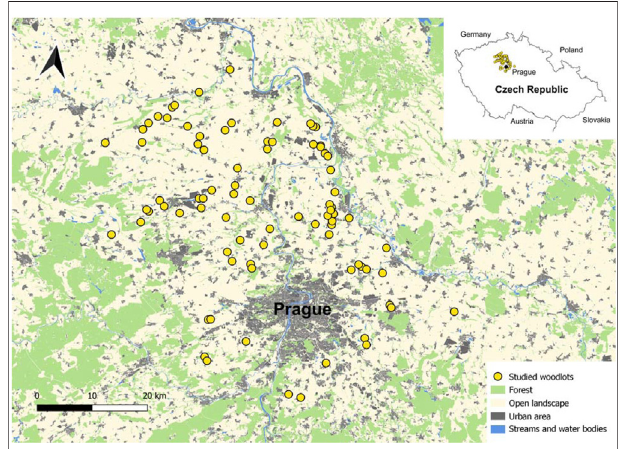
FIGURE 1 | Studied woodlots (yellow dots) on a map showing the main landcover types in the Czech Republic. Inset shows the position of the study area within the Czech